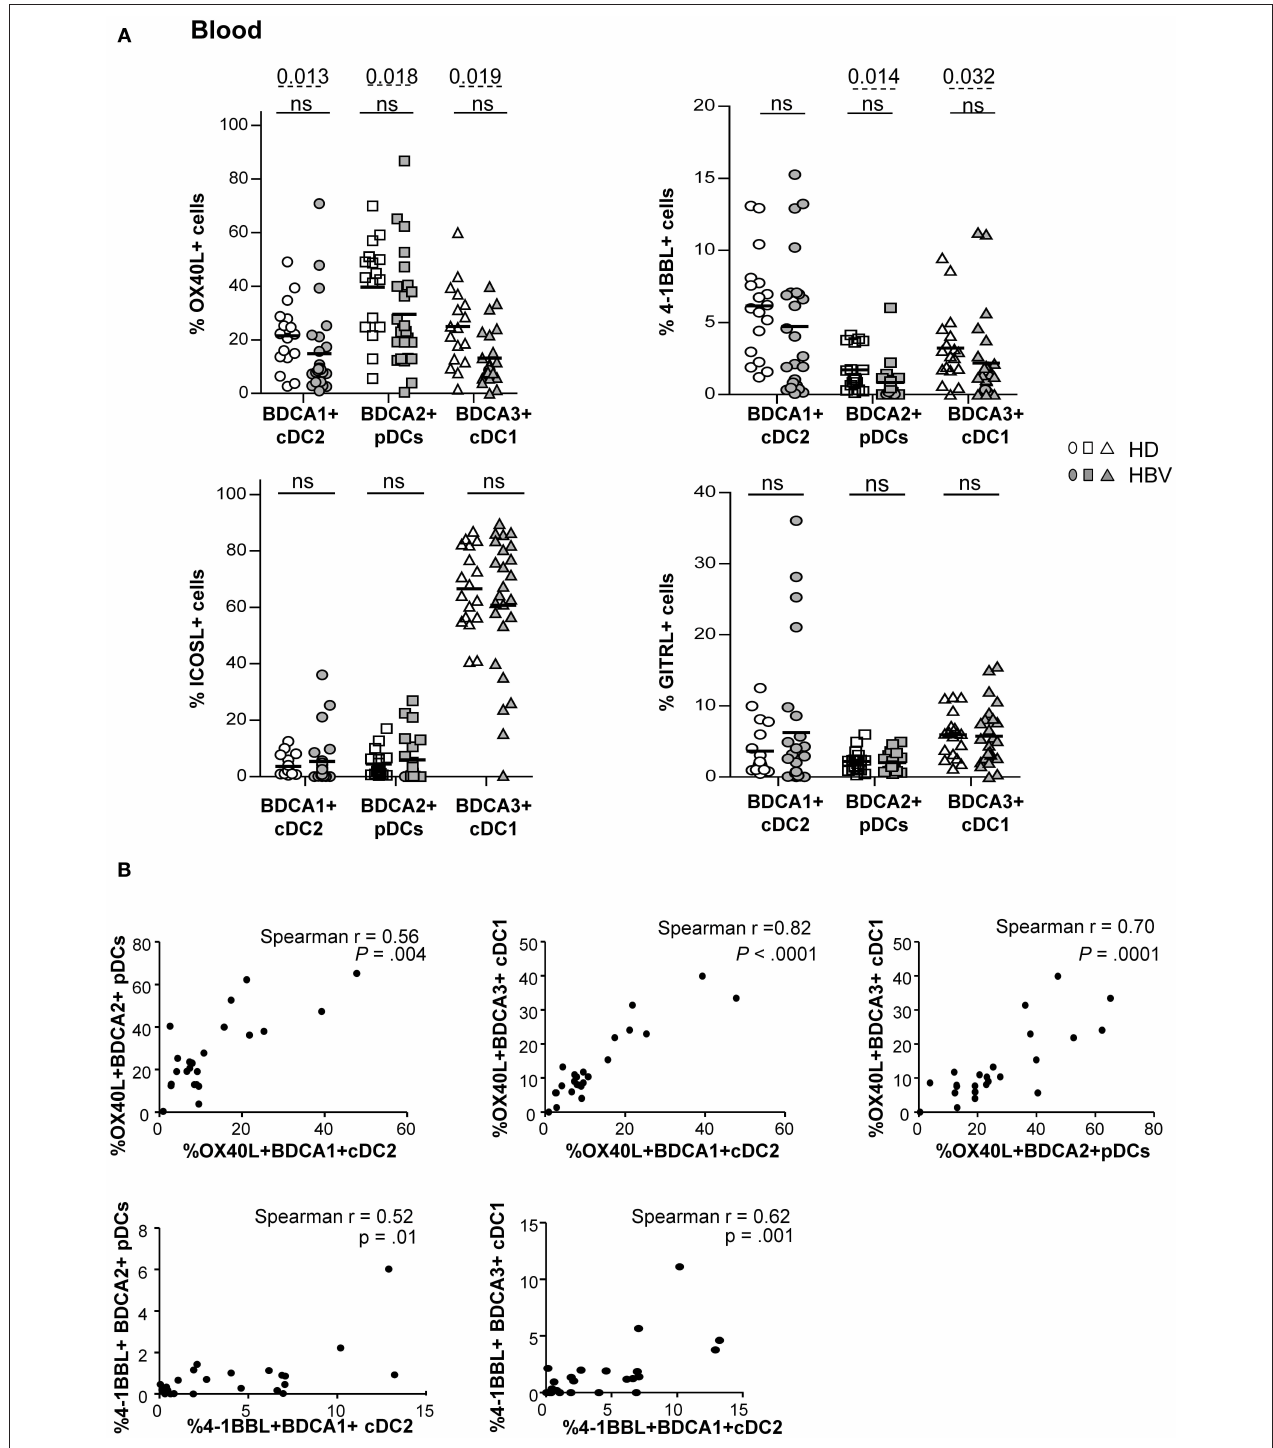
FIGURE 2 | Impaired OX40L and 4-1BBL co-stimulatory molecules expression on peripheral DC subsets from chronic HBV patients. Co-stimulatory molecules expression was determined by flow cytometry on peripheral DC subsets among fresh PBMCs isolated from HD and HBV patients. (A) Percentages of cDC2, pDCs, and cDC1 expressing OX40L, 4-1BBL, ICOSL, and GITRL within PBMCs. Open symbols, HD ( n = 17–18); filled symbols, HBV ( n = 23–25). Bars indicate mean. P -values were calculated using the 2-way-RM ANOVA test (straight line) and the Mann-Whitney test (dashed lines). (B) Spearman’s correlations of OX40L and 4-1BBL expression between peripheral cDC2, pDC, and cDC1 subsets in chronic HBV patients ( n = 29–31).